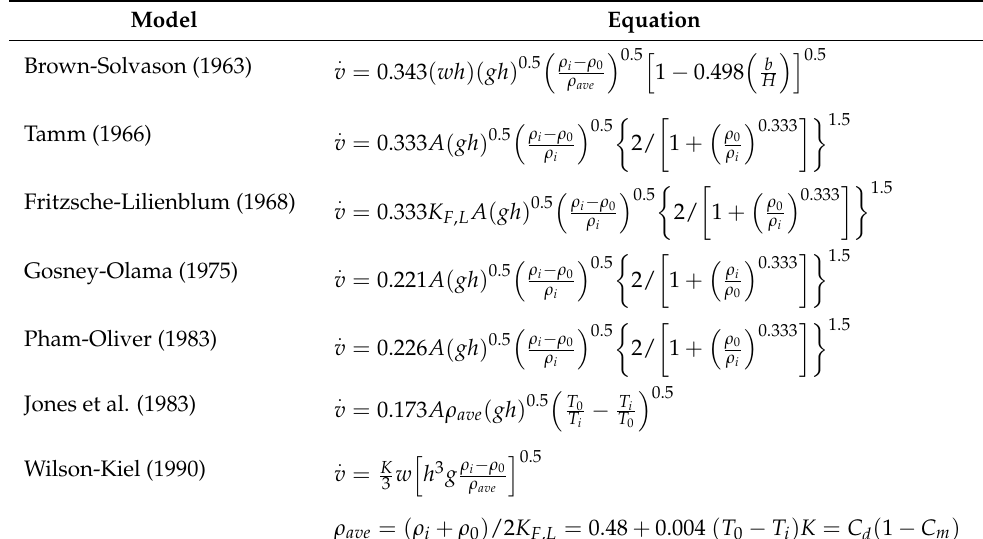
Table 17. Empirical models for air infiltration rate calculation. Reprinted from ref. [86], Copyright (2019), with permission from